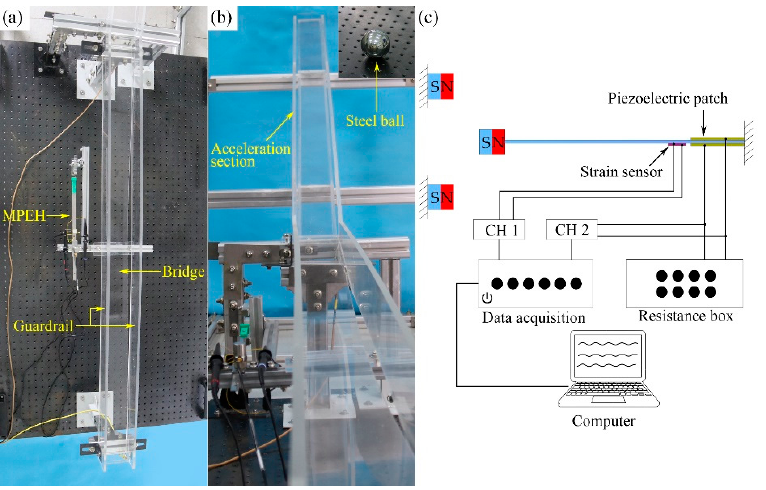
Figure 5. The experimental setup: ( a ) test section, ( b ) acceleration section, and ( c ) schematic diagram of equipment.